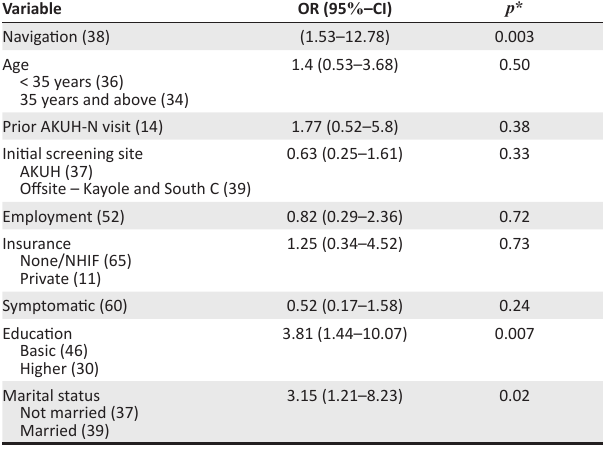
TABLE 4: Factors associated with return in patients with abnormal clinical breast examination finding.